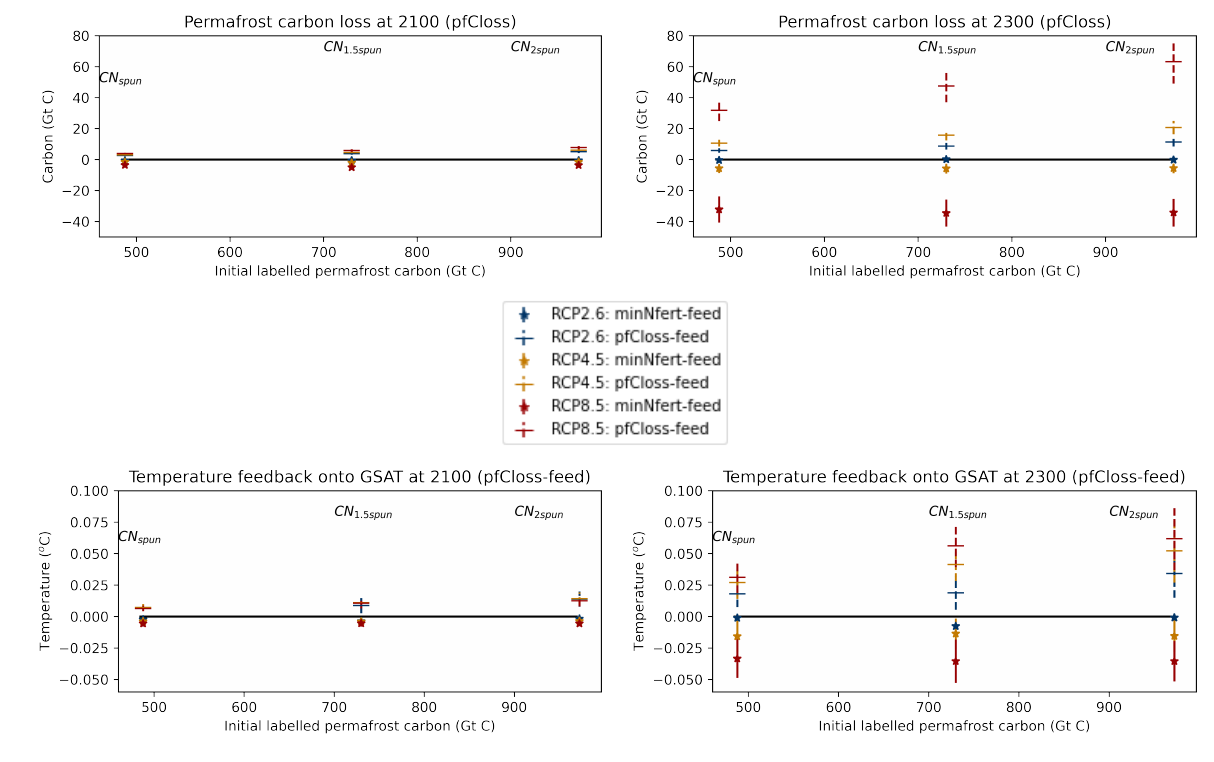
Figure 9. Permafrost carbon loss (pfCloss) and permafrost carbon feedback (pfCloss-feed) for the different RCP scenarios. Additionally shown, for comparison purposes, are the impacts of increasing the available mineral nitrogen in the soil on the carbon emissions and the global temperature feedback